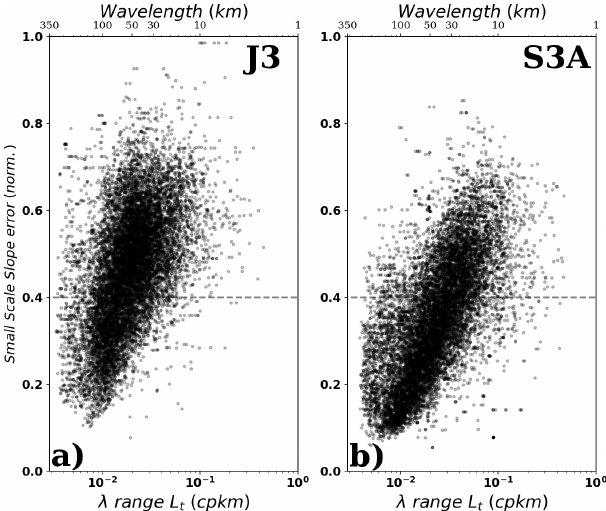
Figure 9. Error in the determination of the small-scale spectral slope plotted against the wavelength range between the computed intercept scale and 30km wavelength (noise level limit) for Jason- 3 (a) and Sentinel-3A (b)